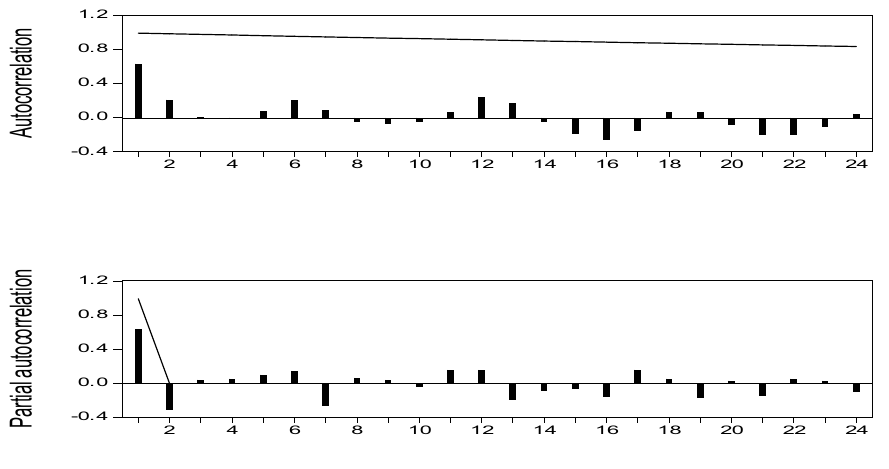
Fig. 4. Construction materials group ARMA